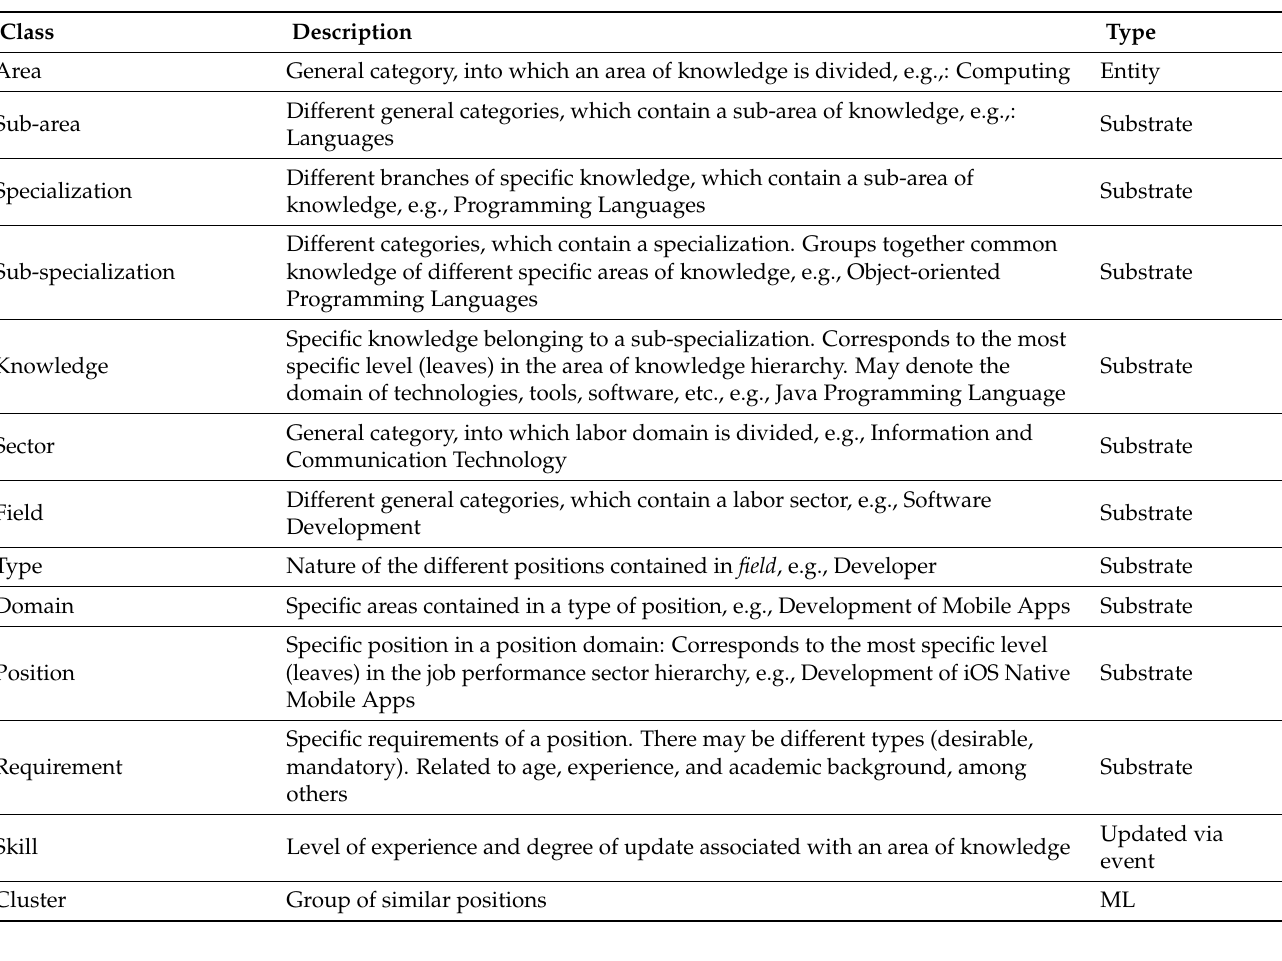
Table 3. Classes of